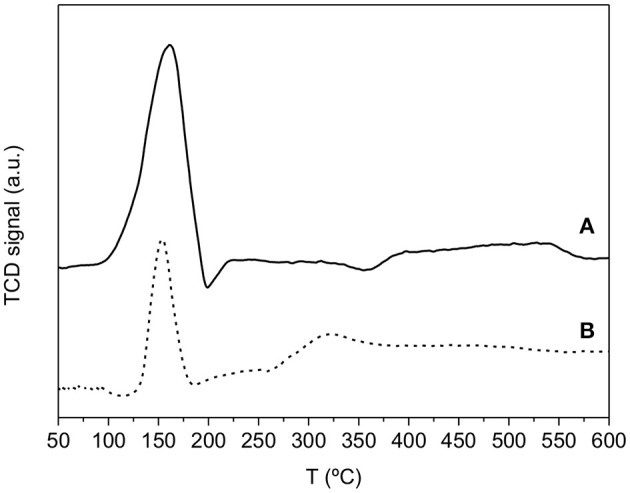
TPR profiles of Pd-Cu loaded on TiO2
(A) and on 20CNT-TiO2
(B).